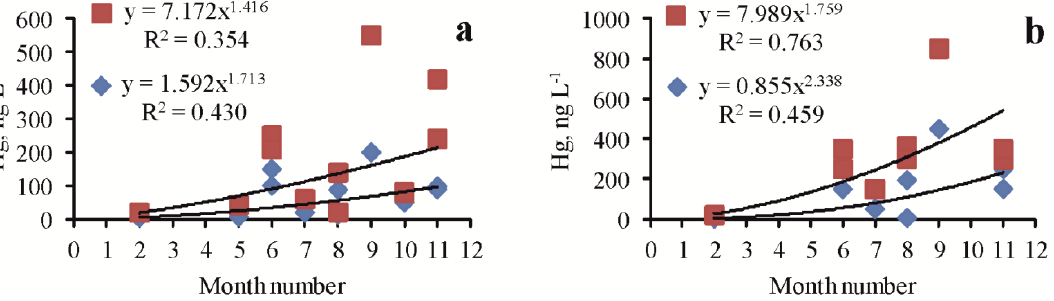
Figure 4. Seasonal changes in the Hg total content (red squares) and suspended form (blue rhombus) in the lakes Kiyatskoe ( a ) and Kirleutskoe ( b ).